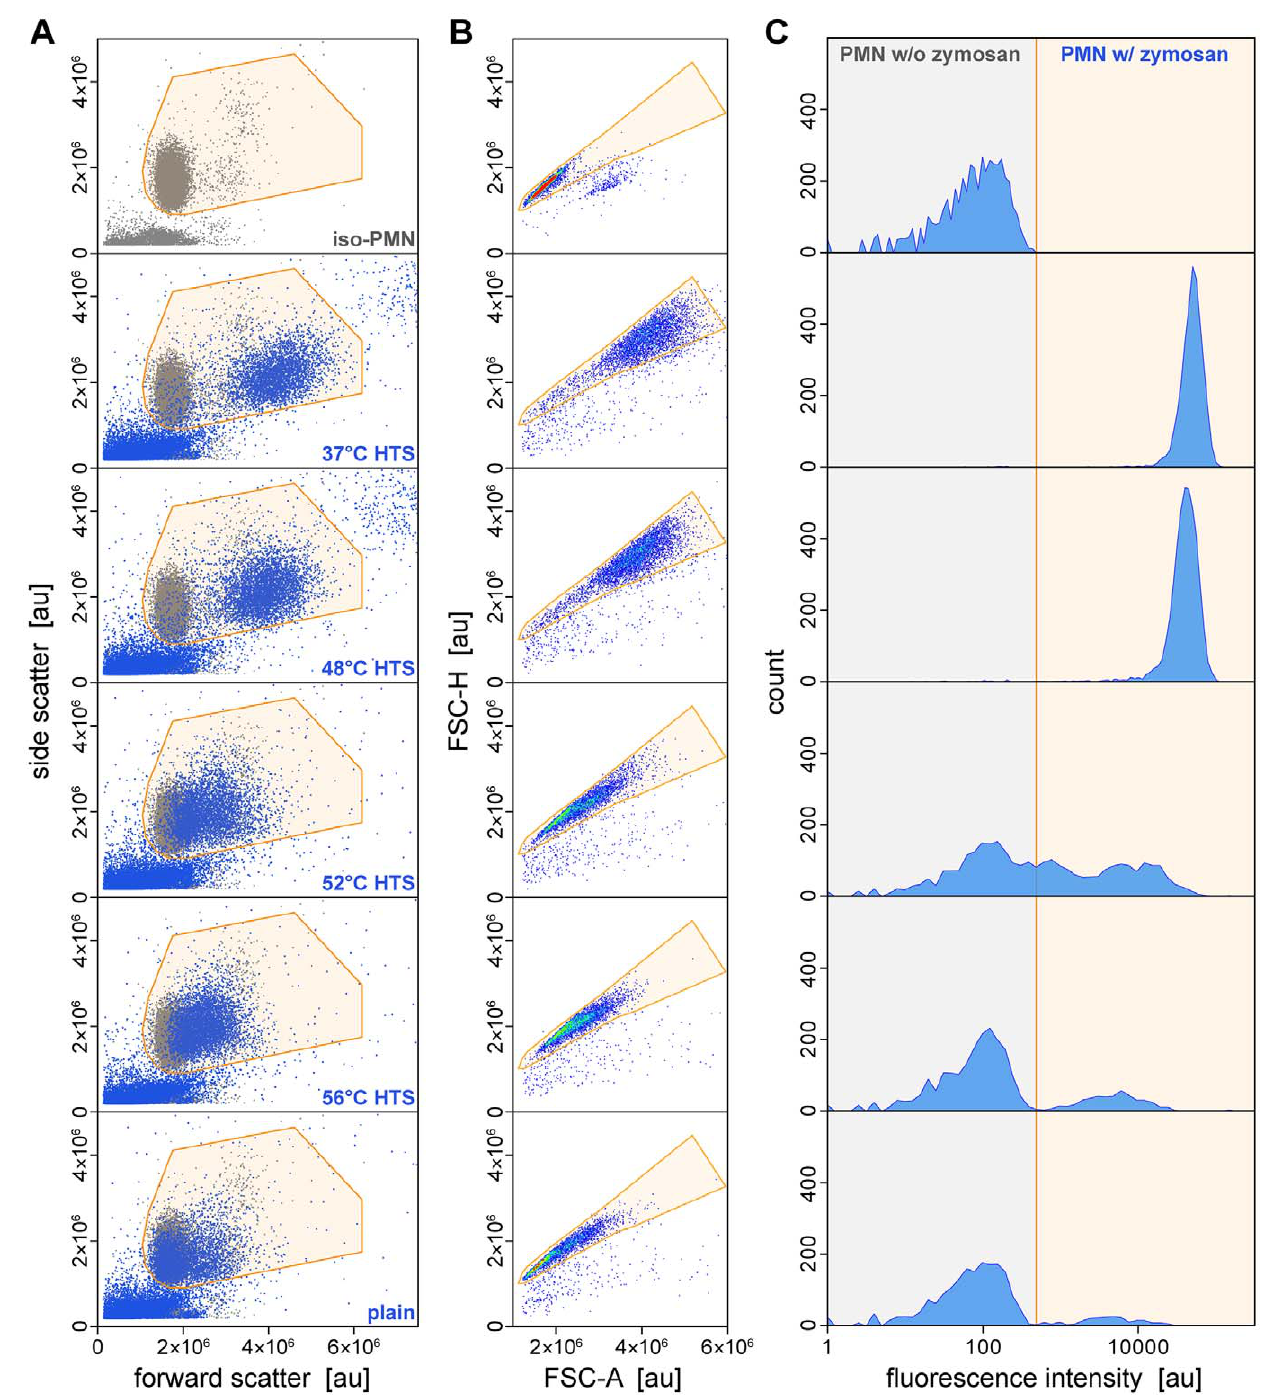
Figure 5. FCM analysis of bulk interactions of human neutrophils with zymosan particles in differentially heat-treated serum (HTS). ( A ) Plots of forward versus side scatter were used to delineate the region of FCM events that contains neutrophils. The scatter data of purified neutrophils ( top panel ) were included in all other panels for comparison ( gray symbols ). ( B ) Forward scatter height-versus-width density plots of the FCM events of the neutrophil gate defined in (A). These plots were used to further discriminate single-neutrophil events from coincidence events. ( C ) Histograms of the FITC fluorescence intensity of the events of the gate of (B) reveal varying degrees of neutrophil association with fluorescent zymosan particles. Also shown are the respective data for isolated neutrophils (obtained in the absence of zymosan; ‘‘iso-PMN’’; top row ), and for a mixture of neutrophils and un-opsonized zymosan (negative control; ‘‘plain’’; bottom row ). doi:10.1371/journal.pone.0054735.g005 important role in the recognition of fungi opsonized with normal temperature window that can unmask the contribution of co- (untreated) serum. Our experiments have thus identified a narrow opsonization of fungal surfaces with IgG to the recognition of these